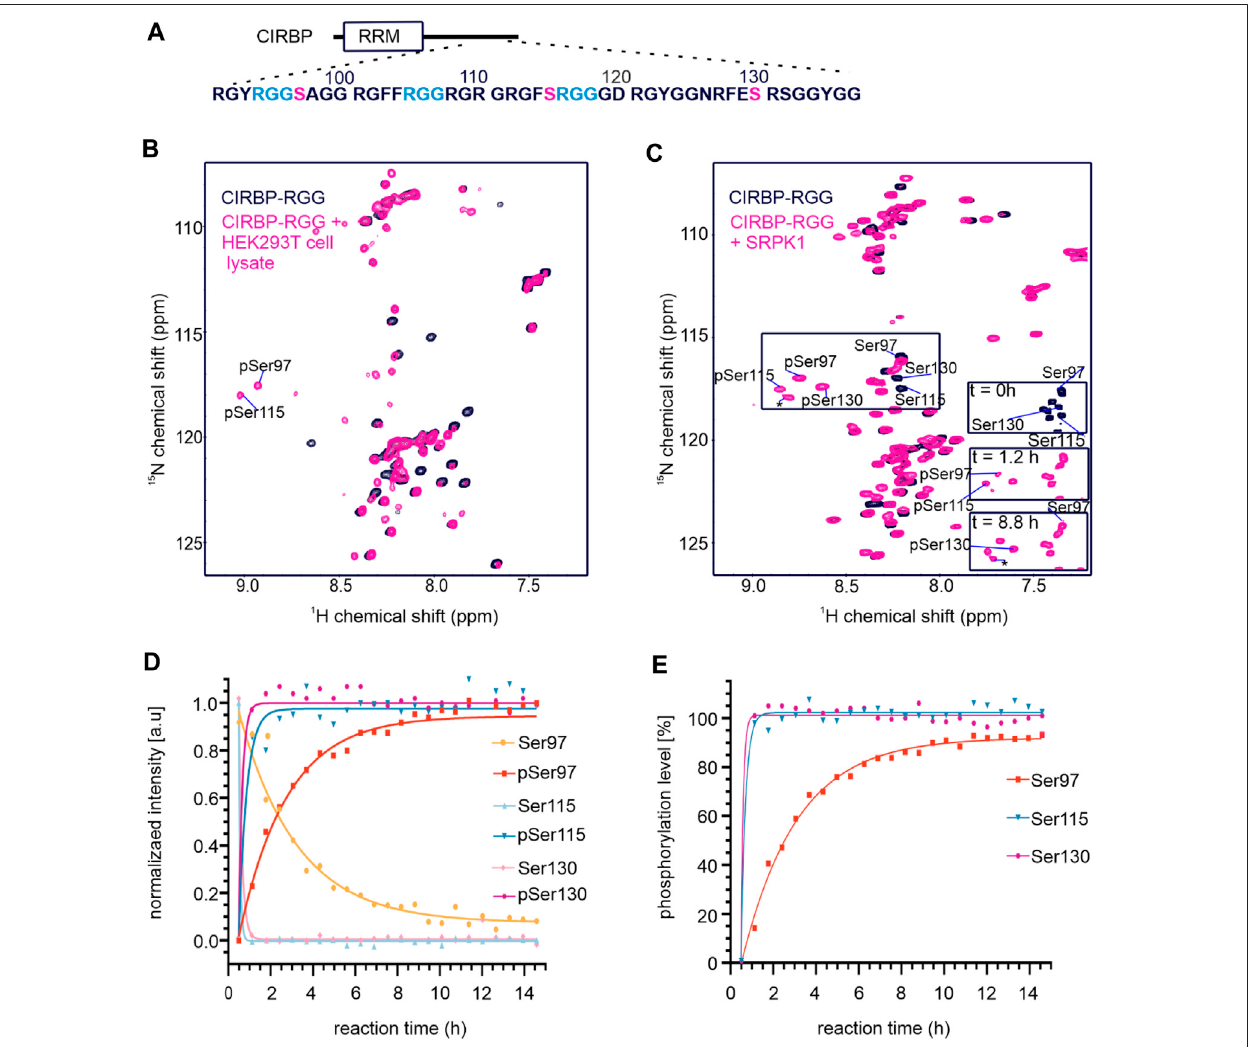
FIGURE1| CIRBP-RGGisphosphorylatedbySRPK1 invitro . (A) ArchitecturalorganizationofCIRBPshowingtheRRM(RNA-recognitionmotif)andthesequence of the CIRBP-RGG containing the three RGGs (blue) with adjacent serine residues (magenta). (B) Overlay of 1 H- 15 N HSQC spectra of 15 N-labeled CIRBP-RGG (black) with repuri fi ed 13 C- 15 N-labeled CIRBP-RGG after incubation with HEK293T whole-cell lysate (magenta). Cross peaks for phosphorylated serine residues assigned by triple resonance experiments are labeled. (C) 1 H- 15 N HSQC spectrum of 100 µM 15 N-labelled CIRBP-RGG in the absence (black) and presence of 50 µM SRPK1 and 10 mM ATP (magenta). Resonance peaks corresponding to phosphorylated serine residues are marked. Both appearance of phosphoserines and disappearance of the corresponding serine signal are shown at the indicated time points on a bottom right part of the spectrum. The cross peak labeled with an asterisk could not be assigned by triple resonance experiments, and may correspond to either an intermediate phosphorylation state, or to non-assigned phosphosite (e.g. Ser132 is a phosphositereportedinPhosphoSitePlusdatabase,andtheshiftofitsresonancepeakwasdetectedinNMRexperiments(notshown)). (D) ChangeofNMRcrosspeak signal intensity of both appearing phosphoserines and disappearing serines is shown over time (sample from Figure 1C ). (E) The graph shows the calculated phosphorylation level for serines 97, 115, and 130 in CIRBP-RGG after incubation with SRPK1 (sample from Figure 1C ).